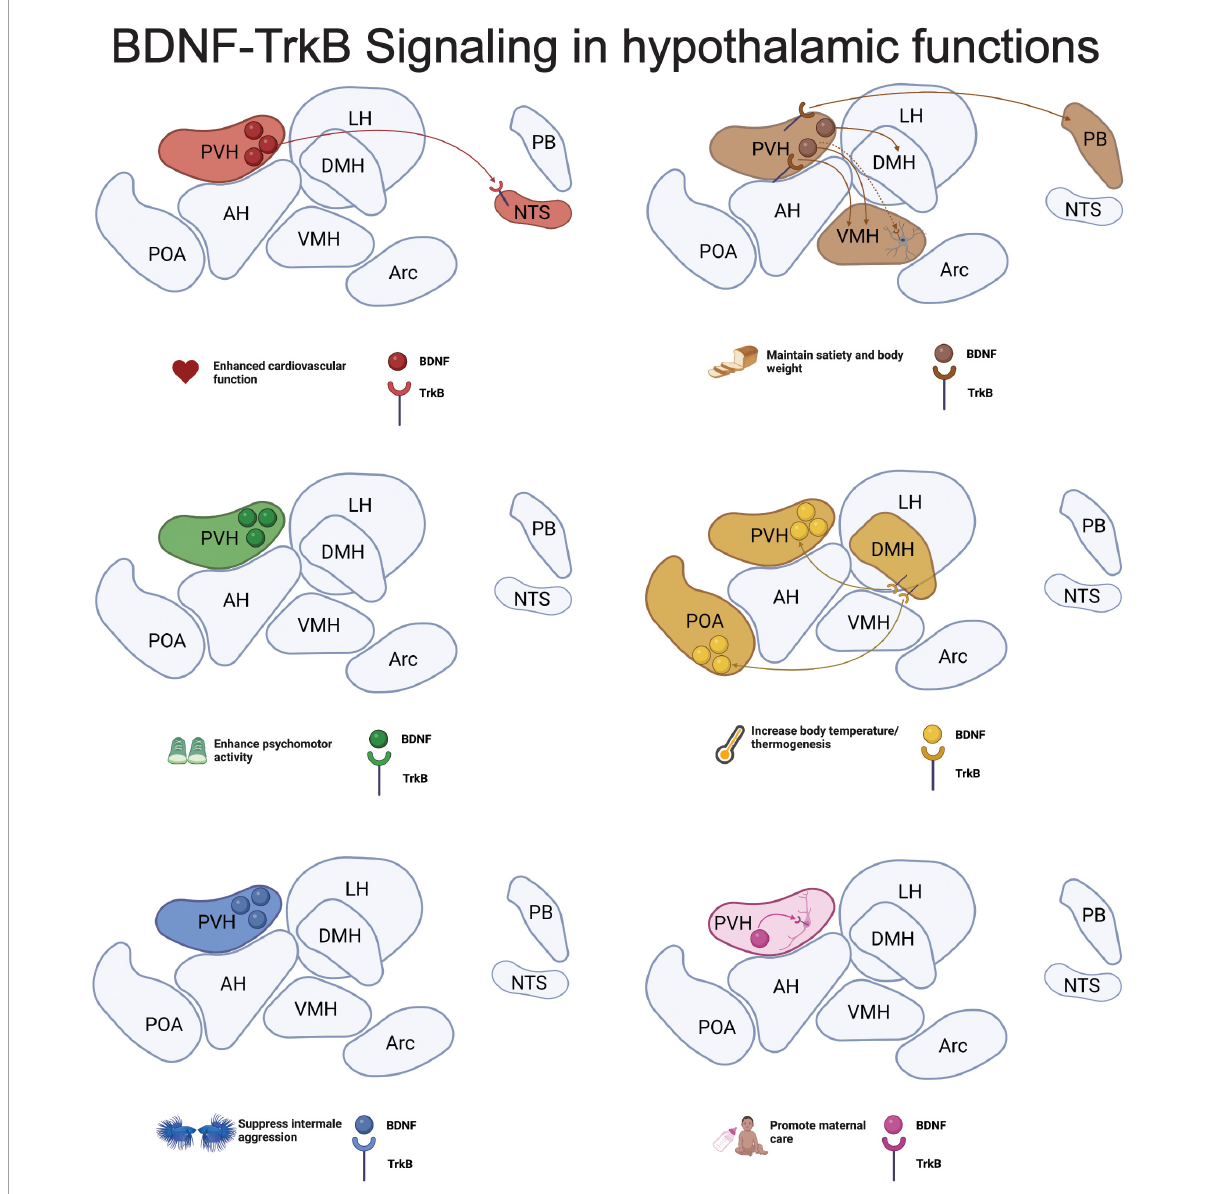
FIGURE1 Brain-derived neurotrophic factor (BDNF)-tropomyosin-related kinase B (TrkB) signaling in hypothalamic functions. Here we summarize the current findings on the role of BDNF and TrkB signaling in hypothalamic nuclei discussed in each section of this review. Much of the